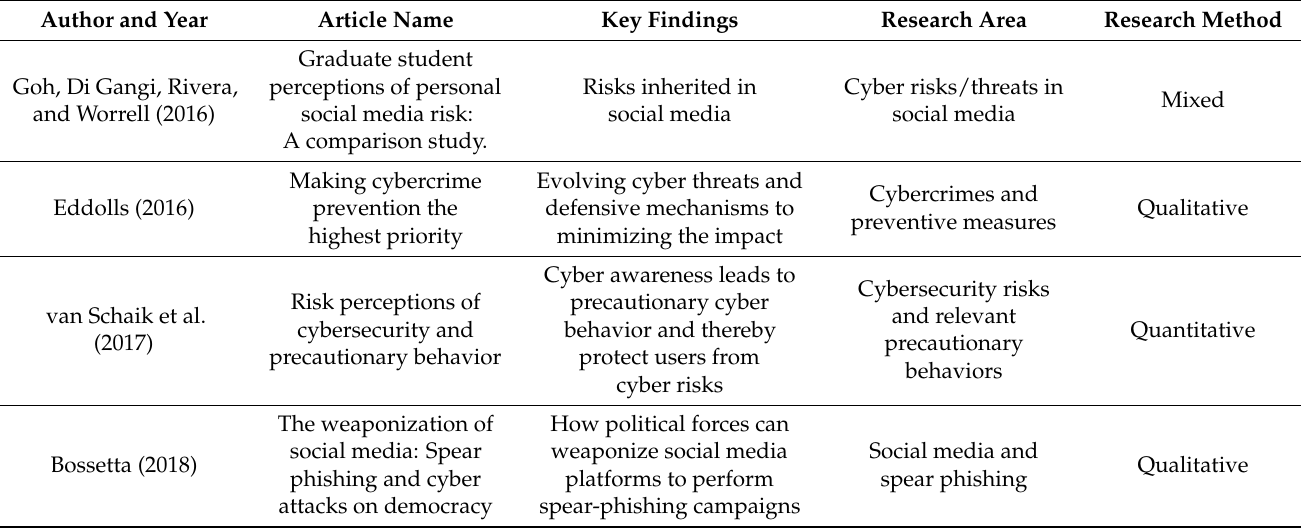
Table A2. Cyber threats in social